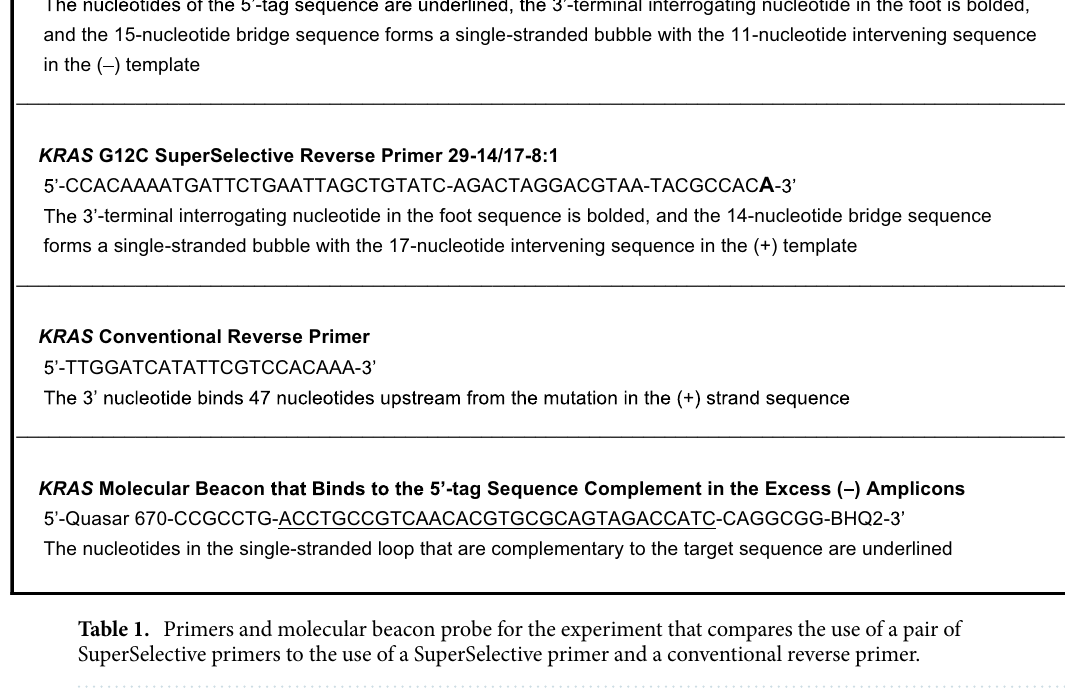
-terminal interrogating nucleotide in the foot is bolded, and the 15-nucleotide bridge sequence forms a single-stranded bubble with the 11-nucleotide intervening sequence in the ( )